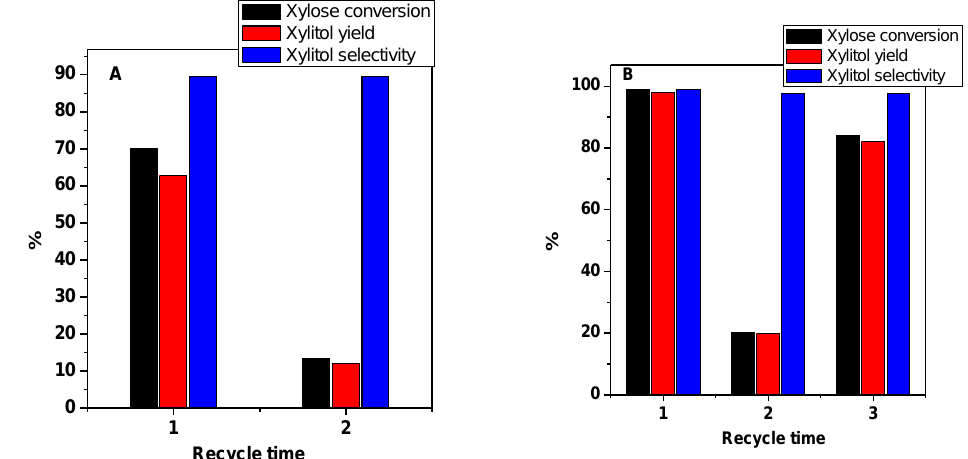
Figure 8. Reusability of ( A ) Ni / AC and ( B ) Ni-Re / AC(n Ni :n Re = 1:1) catalysts. Reaction conditions: 20 mL deionized water, 0.1 g catalyst, 2 MPa of H 2 , and 140 °C for 1 h.